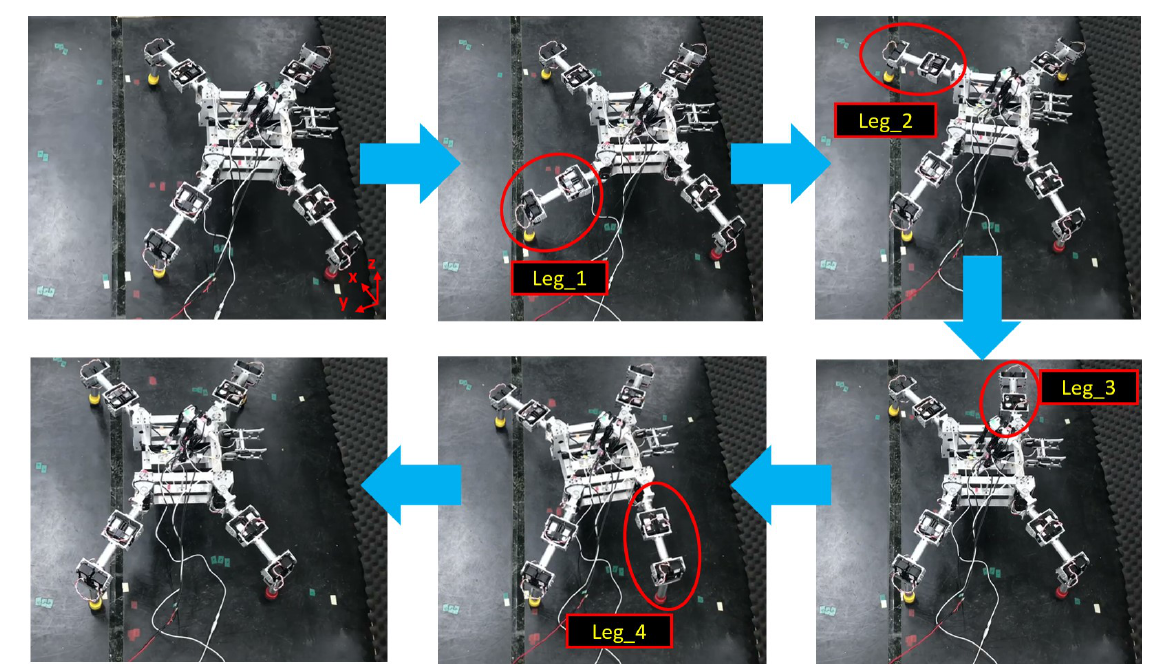
Figure 4. Walking sequence for a single robot. Algorithm 1: Pseudo-code of the robot’s walking